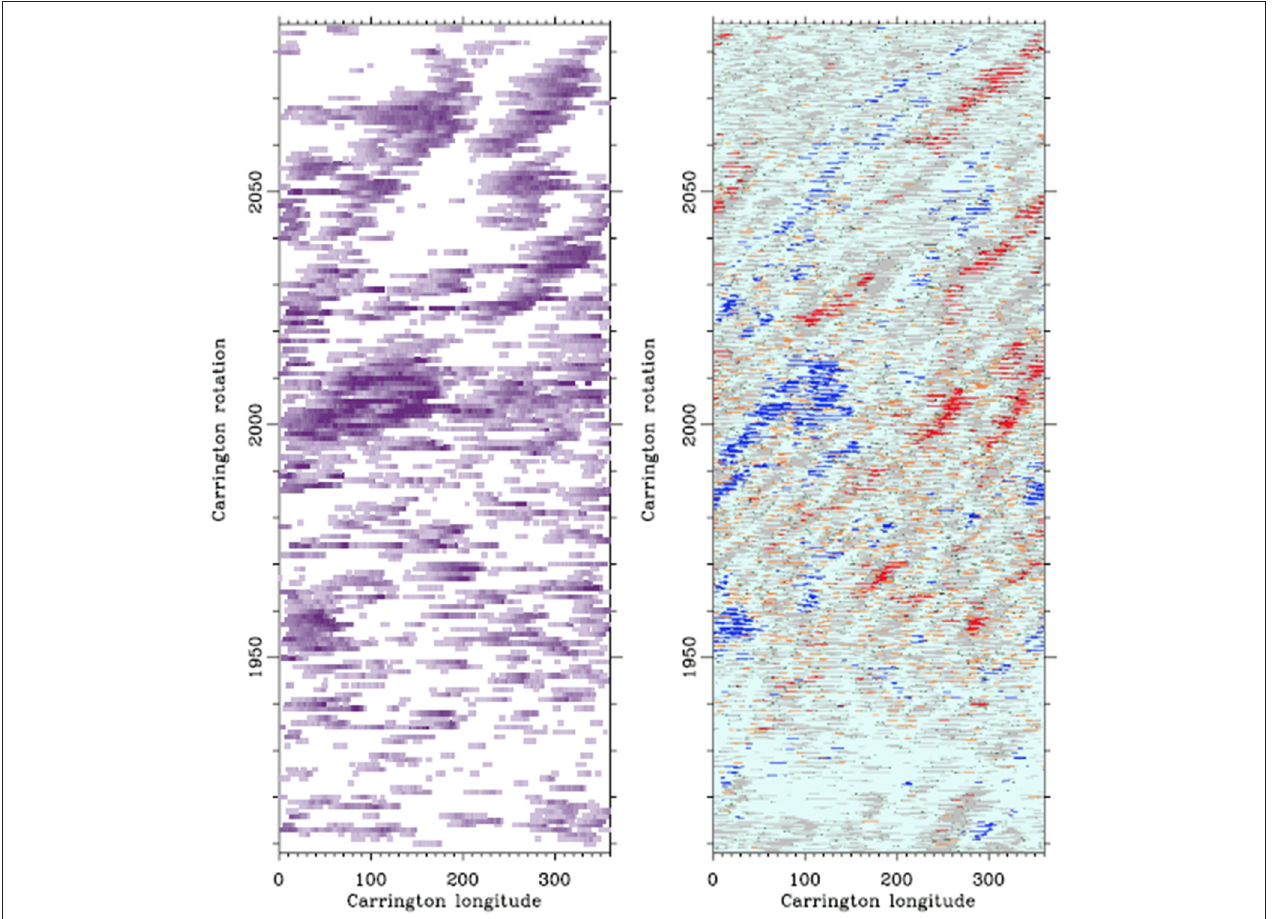
FIGURE 10 | CR stackplots showing (left) in-ecliptic OMNI wind speeds and (right) surface features from the McA, both for the duration of SC 23. In the left panel, white denotes v ≤ 450k ms − 1 and increasingly darker shades of purple eventually saturate at the darkest color for v ≥ 750k ms − 1 . Longitudes have been offset by 50.55 ◦ , or 3.83 days, to account for propagation from the Sun to 1AU at a mean speed of 450k ms − 1 . The right panel shows equatorial ( ± 20 ◦ from equator) features, with blue [red] showing coronal holes of positive [negative] polarity, cyan [gray] showing quiet regions with predominantly positive [negative] polarity, orange indicating sunspots, and green indicating filaments; from Cranmer et al.